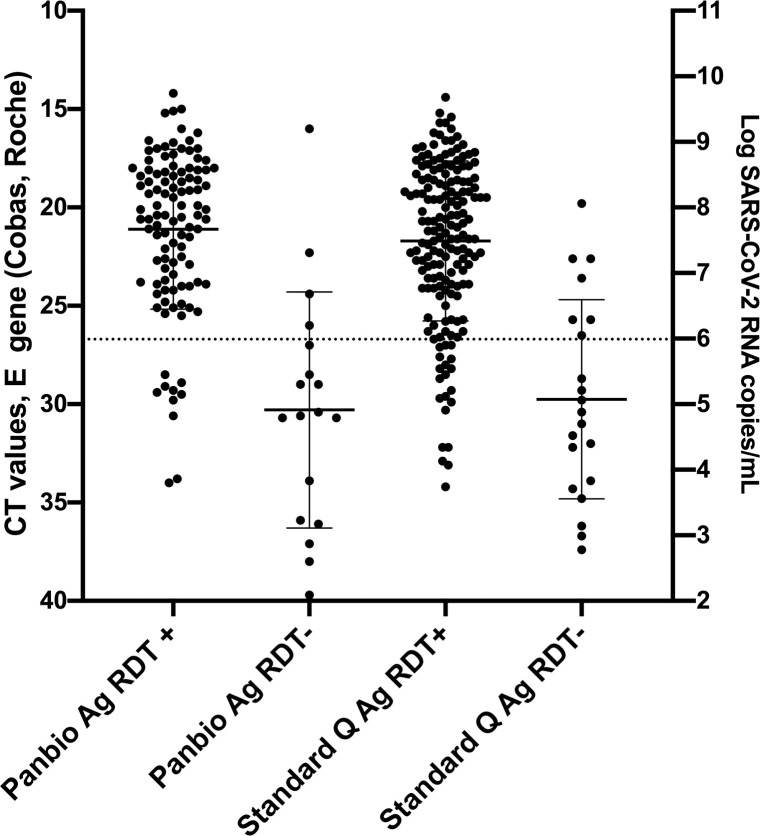
Ct values, viral load and Ag-RDT results for RT-PCR-positive individuals tested with Standard Q (n = 191) and Panbio (n = 124).Horizontal bars represent median and standard deviation. Dotted line: Ct value of 26.7 or 1E6 SARS-CoV-2 RNA copy numbers/mL.